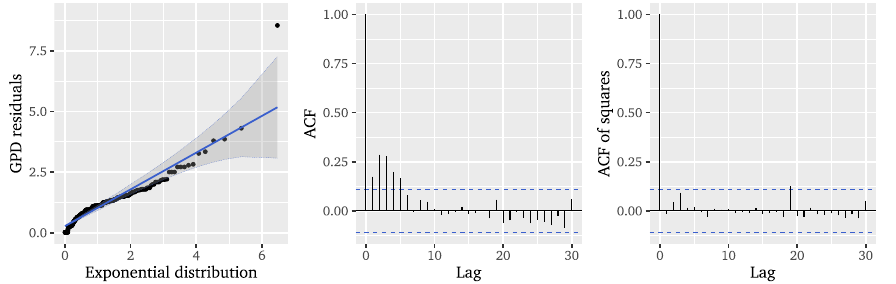
Figure 4. Unit exponential QQ plot and autocorrelation functions for the GPD residuals of the Hawkes-POT model.